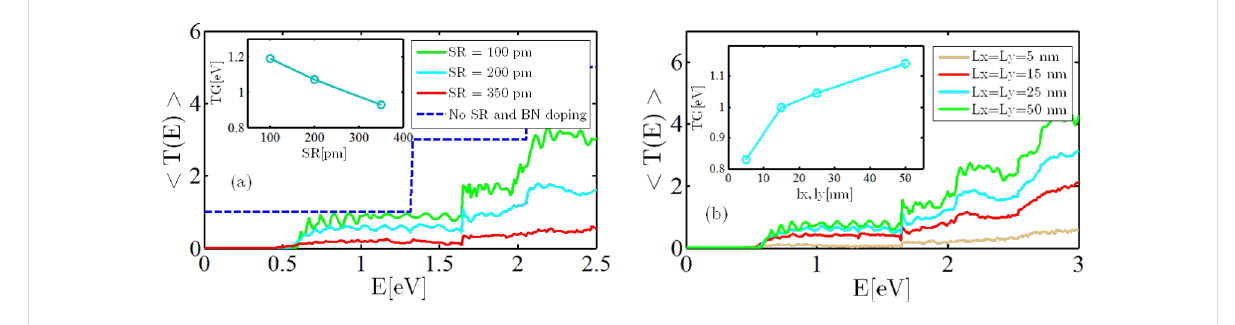
Figure 2: (a) Averaged transmission of 10 nm length 4h-2BN-ZGNR as function of the energy for various SR amplitudes ( l x = l y = 25 nm). The dashed-blue line belongs to the flat channel (a 4h-2BN-ZGNR without SR). The inset shows the transport gap versus SR amplitude. (b) Averaged transmission probability of 10 nm length 4h-2BN-ZGNR as function of the energy for various SR correlation lengths ( δ SR = 200 pm). The inset shows the transport gap versus SR correlation length.